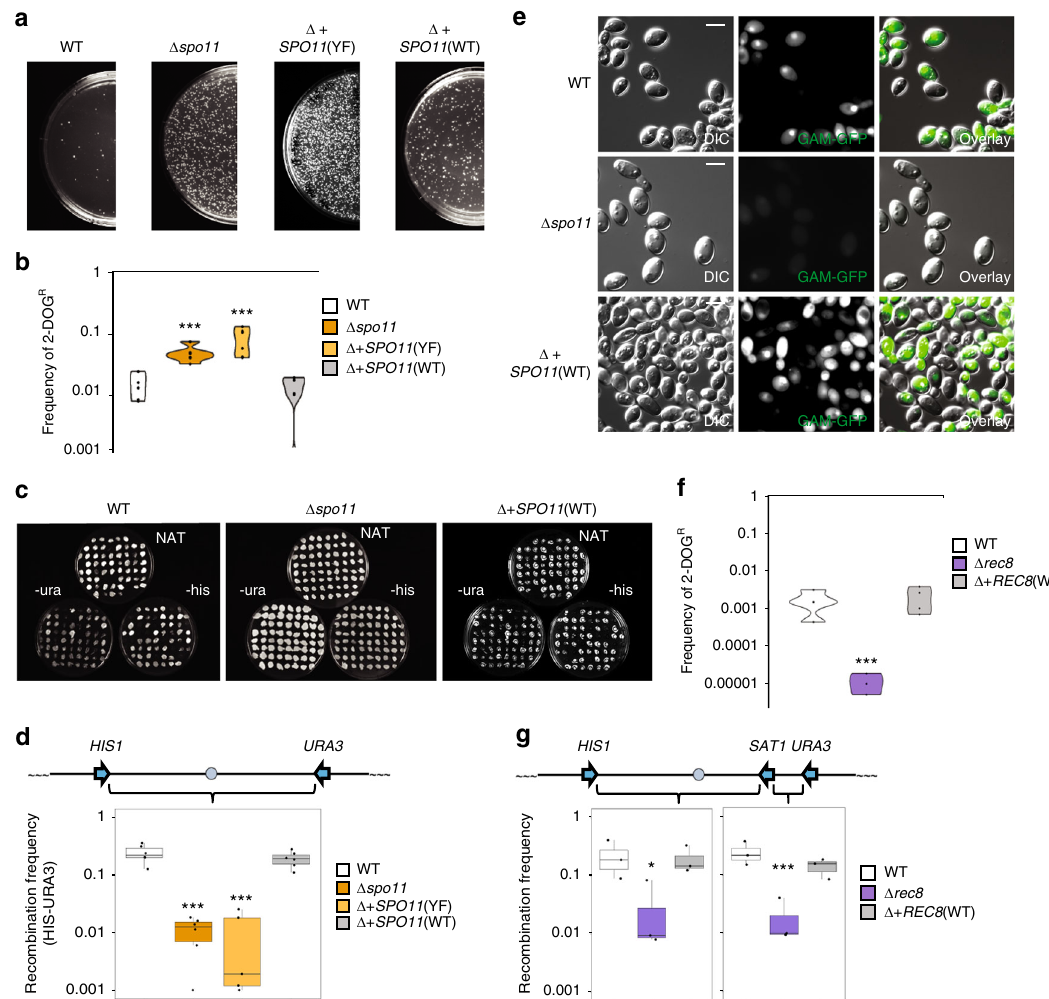
Fig. 2 Homologous recombination during CCL requires the ‘ meiosis ’ factors Spo11 and Rec8. a Images of plates illustrating 2-DOG R colonies produced by CCL in C. albicans wildtype and Δ spo11 tetraploid strains, as well as in Δ spo11 strains complemented with wildtype SPO11, SPO11 (WT), or an active site mutant, SPO11 (YF). b Quanti fi cation of the frequency of 2-DOG R colonies in different strain backgrounds following CCL. n = 6 biologically independent experiments. c Images of plates examining CCL progeny grown on different selective media. d Frequency of recombination in CCL progeny from different strain backgrounds. n = 6 biologically independent experiments. e Analysis of Gam-GFP signal in tetraploid strains with different SPO11 genotypes undergoing CCL. Images shown after 24 h on PRE-SPO medium with 50 μ g/mL doxycycline at 37 °C. Scale bars = 5 μ m. f Quanti fi cation of the frequency of 2-DOG R colonies in different REC8 strain backgrounds following CCL. n = 4 biologically independent experiments. g Frequency of recombination in CCL progeny derived from different REC8 strain backgrounds in HIS1-SAT1 and SAT1-URA3 intervals. n = 3 biologically independent experiments. * denotes p < 0.05. *** denotes p < 0.001 as calculated by two-sample t b , f or Wilcoxon d , g tests. Boxplots are presented as the 25th to 75th percentile with the thick line denoting the median. Whiskers indicate the largest and smallest values within 1.5 × of the interquartile range. White, orange, light orange, and